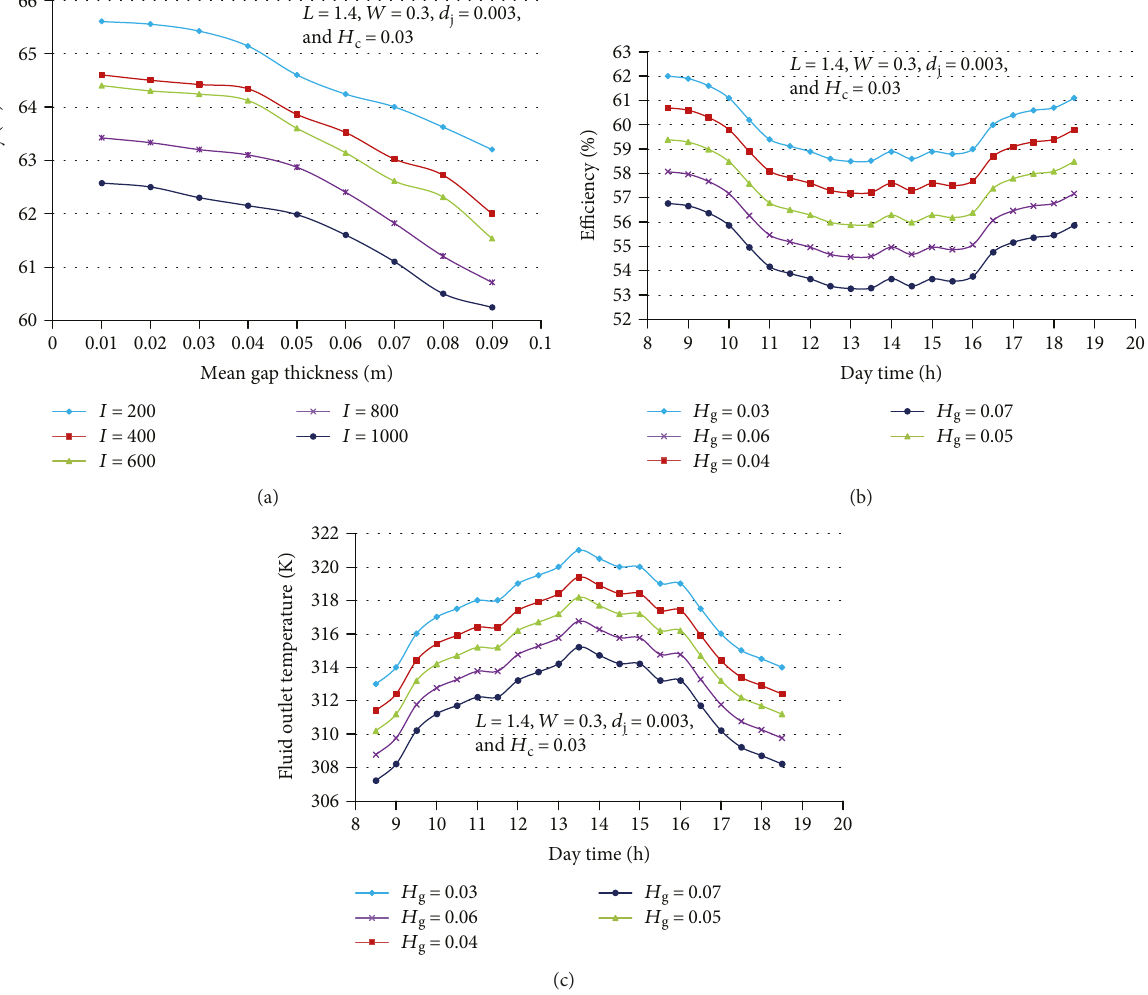
) of the proposed solar air heater. g . (c) Hourly air outlet g